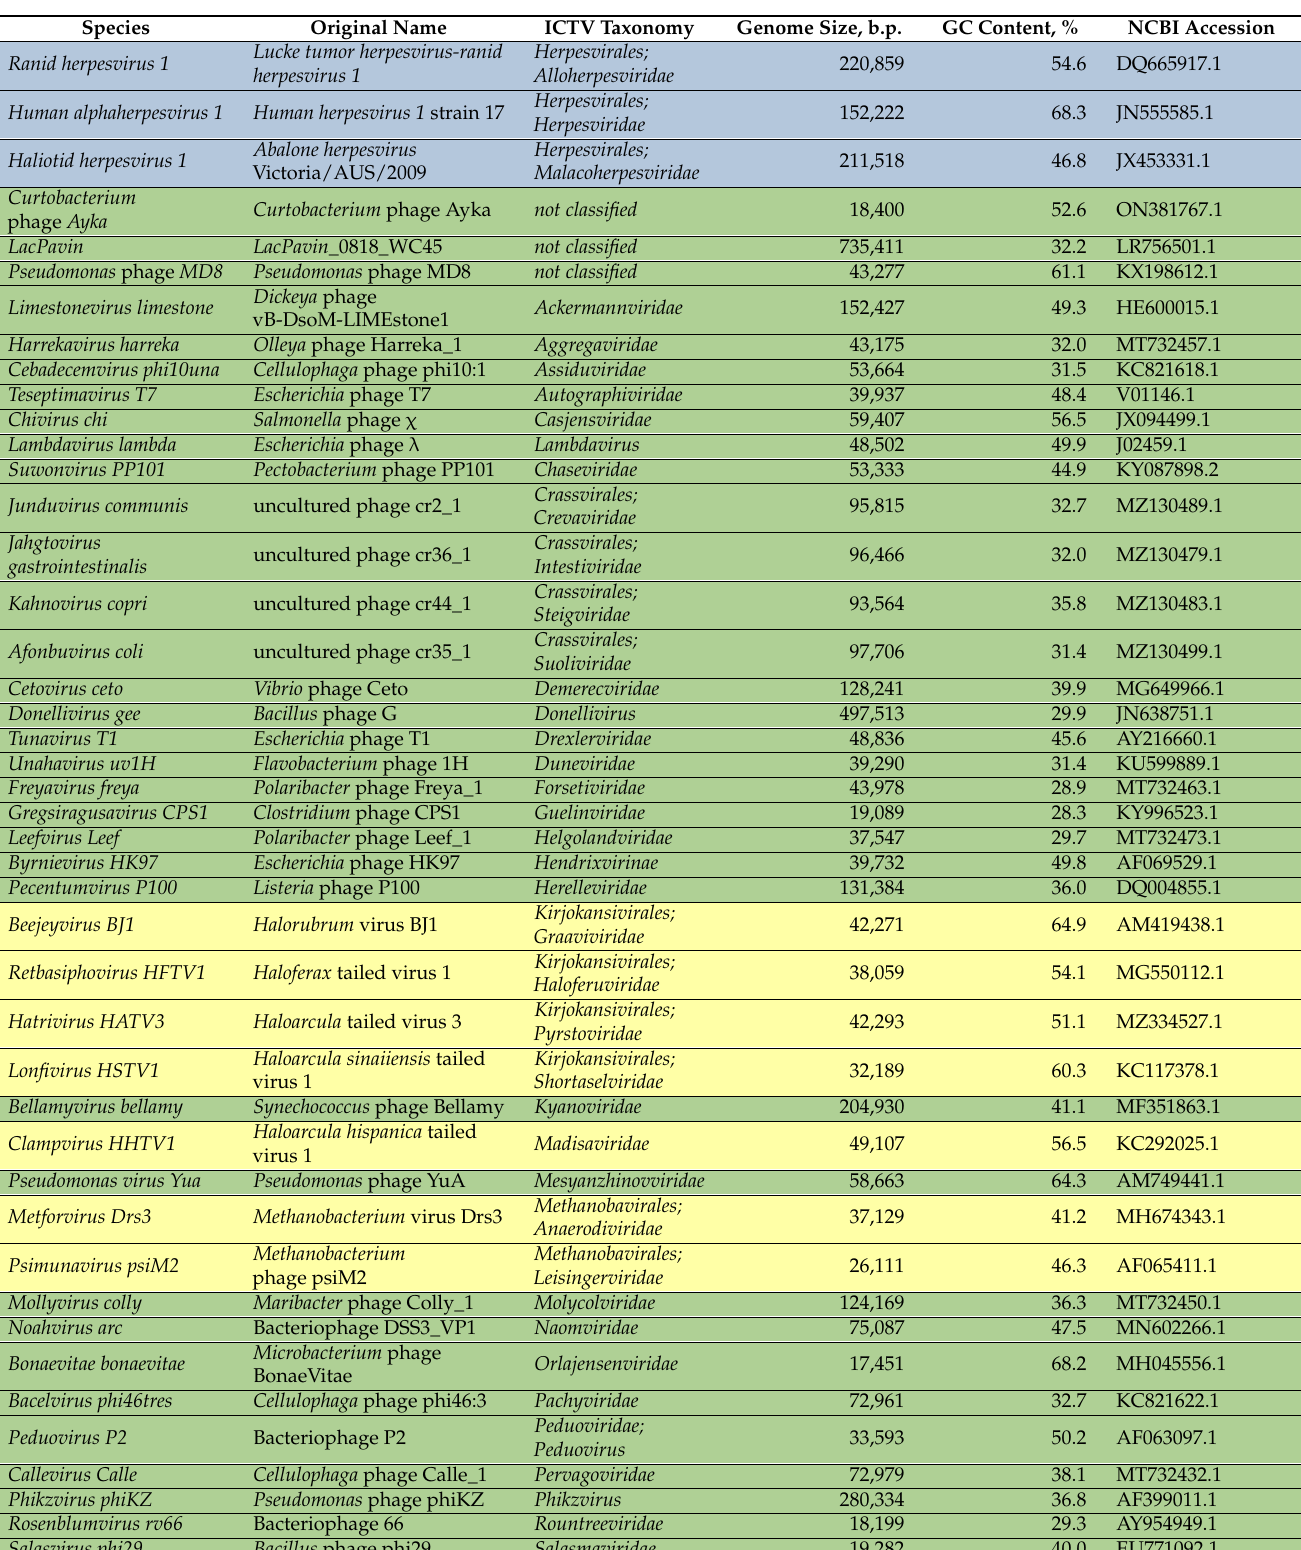
Table 1. List of Duplodnaviria Heunggongvirae representative viruses taken for the analyses and general genomic features. Eukaryotic viruses are coloured blue, bacterial viruses are coloured green, and archaeal viruses are coloured